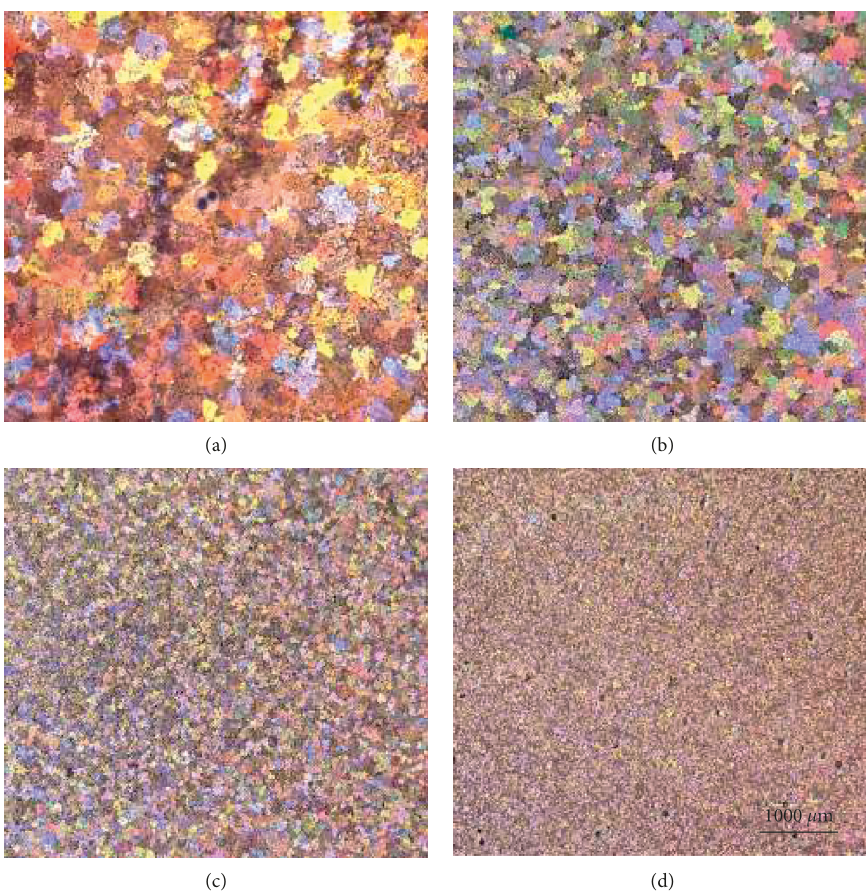
Figure 16: Evolution of the grain size in A356.2 alloy: (a) no addition, (b) Al-10%Ti (0.2%Ti), (c) Al-5%Ti-1%B (0.1%Ti), and (d) Al-4%B (100ppm B). Pouring temperature: 750 ° C; stirring time: 30 minutes.